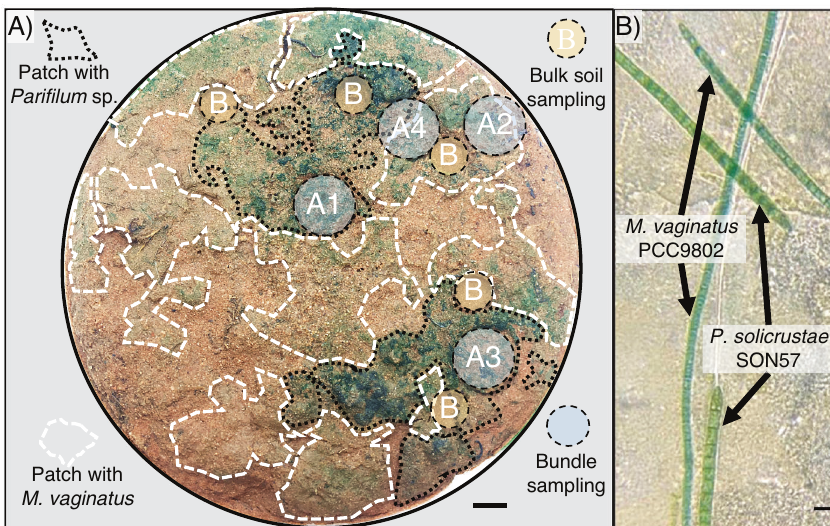
Fig. 1 Patchiness in cyanobacterial populations in a cyanobacterial biocrust at the cm scale. A Patches attributable to M. vaginatus (dashed white lines) and Pari fi lum sp. (dashed black lines) on a rehydrated biocrust are visible through differential coloration. Areas sampled for bulk soil (B) and cyanobacterial bundles (A1-4) are indicated by circles. Scale bar is 1 cm. B Light microscopy image showing trichome color and morphology differences between cultured representative strains M. vaginatus PCC9802 and P. solicrustae SON57 from our culture collection. Scale bar is 10 µm. Images have been optimized in brightness, contrast and color saturation with equal modi fi cation for all